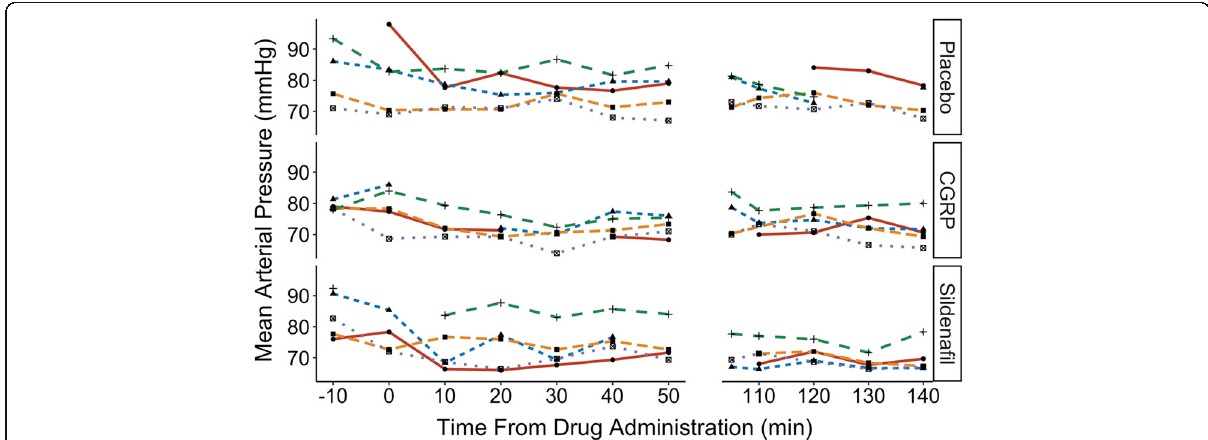
Fig. 5 Mean arterial blood pressure by time in the individual participants after each of the three